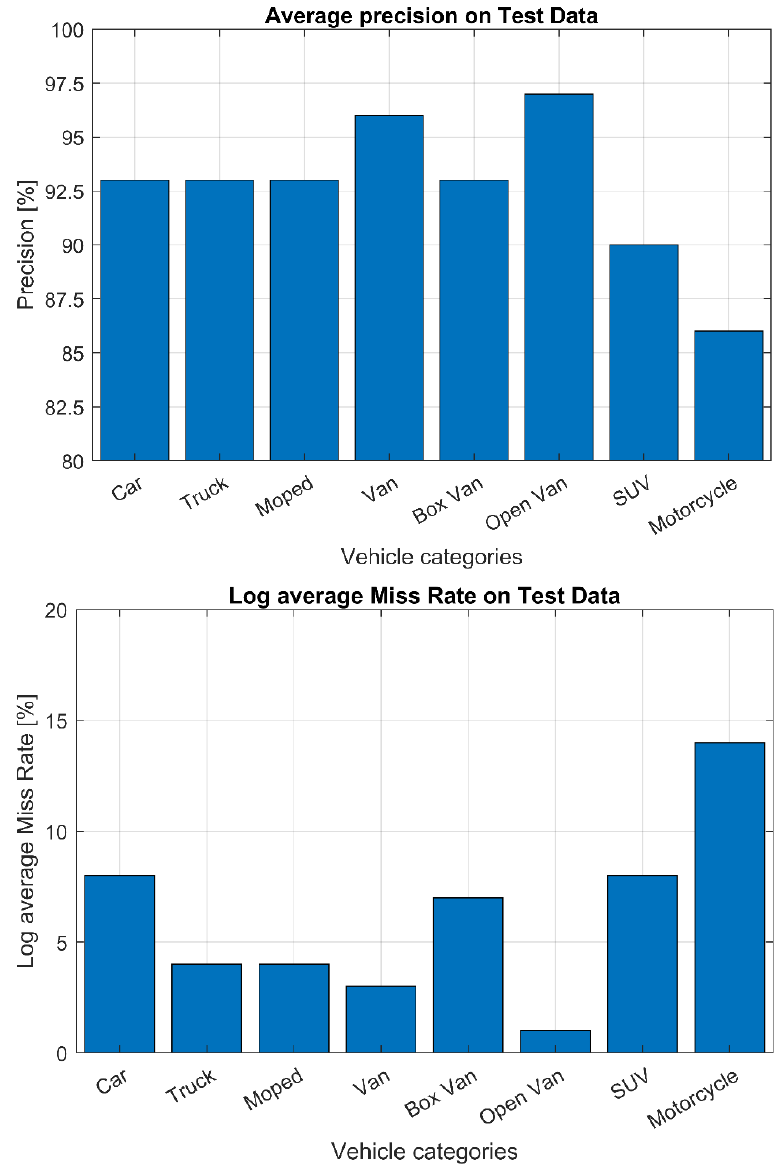
Figure 6. Detection average precision and log average miss rate of the trained Yolov2 model for different vehicle categories, evaluated on a test set.